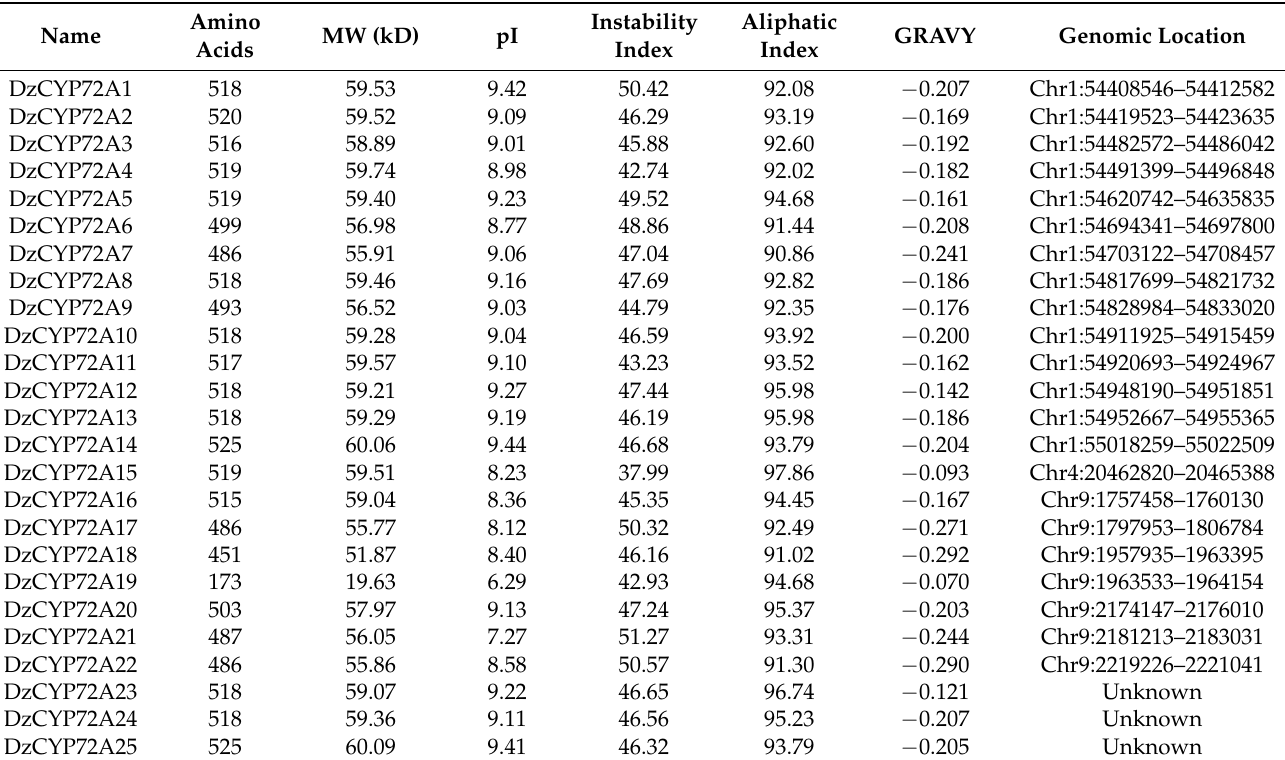
Table 1. Characters of DzCYP72A proteins identified in D. zingiberensis